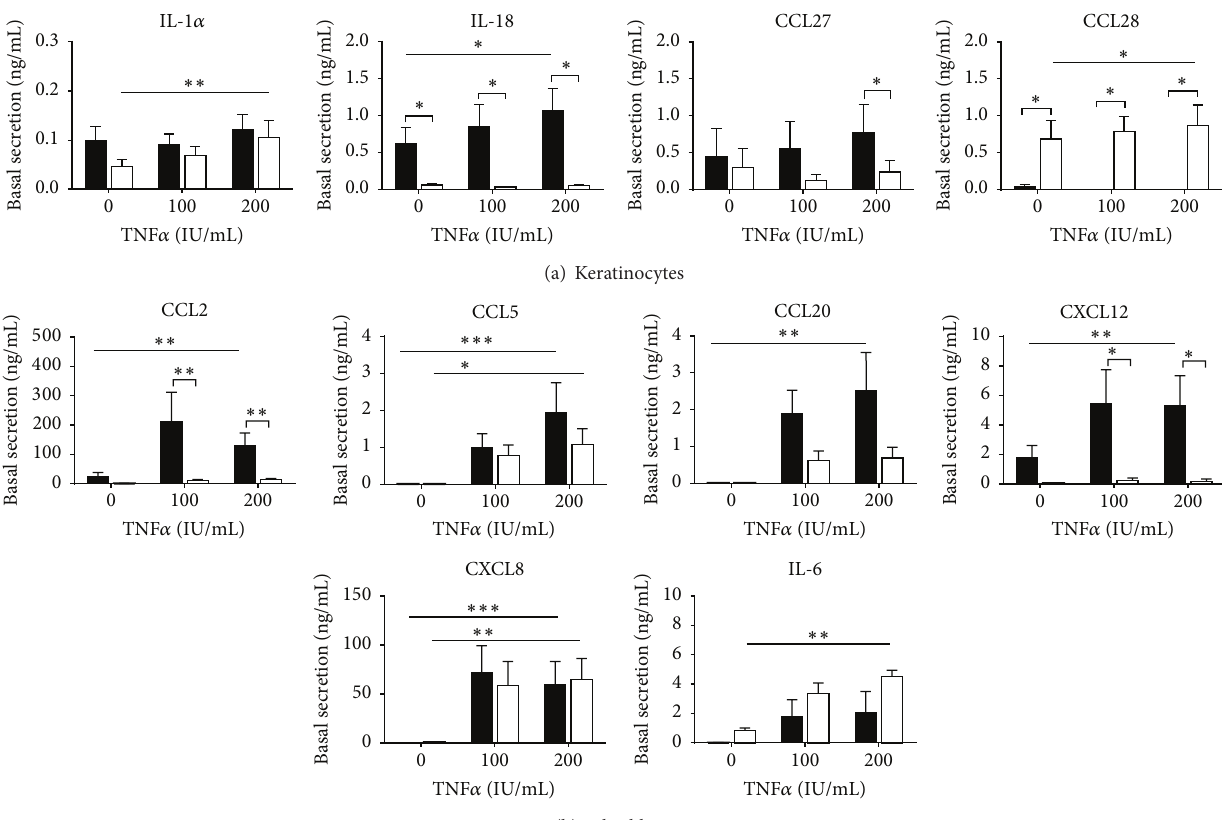
Figure3:DifferentialcytokineandchemokinesecretionbykeratinocytesandfibroblastsinresponsetorhTNF 𝛼 .(a)Skincomparedtogingiva keratinocytes; (b) skin compared to gingiva fibroblasts. Cultures were unexposed or exposed to rhTNF 𝛼 (100 and 200IU/mL) for 24 h in the culture medium. Culture supernatants were collected and analysed by ELISA. Data represent the average of at least 3 individual experiments ± SEM; ∗ 𝑝 < 0.05 ; ∗∗ 𝑝 < 0.01 ; paired Student’s 𝑡 -test for intraskin and intragingiva comparisons, unpaired Student’s 𝑡 -test for skin